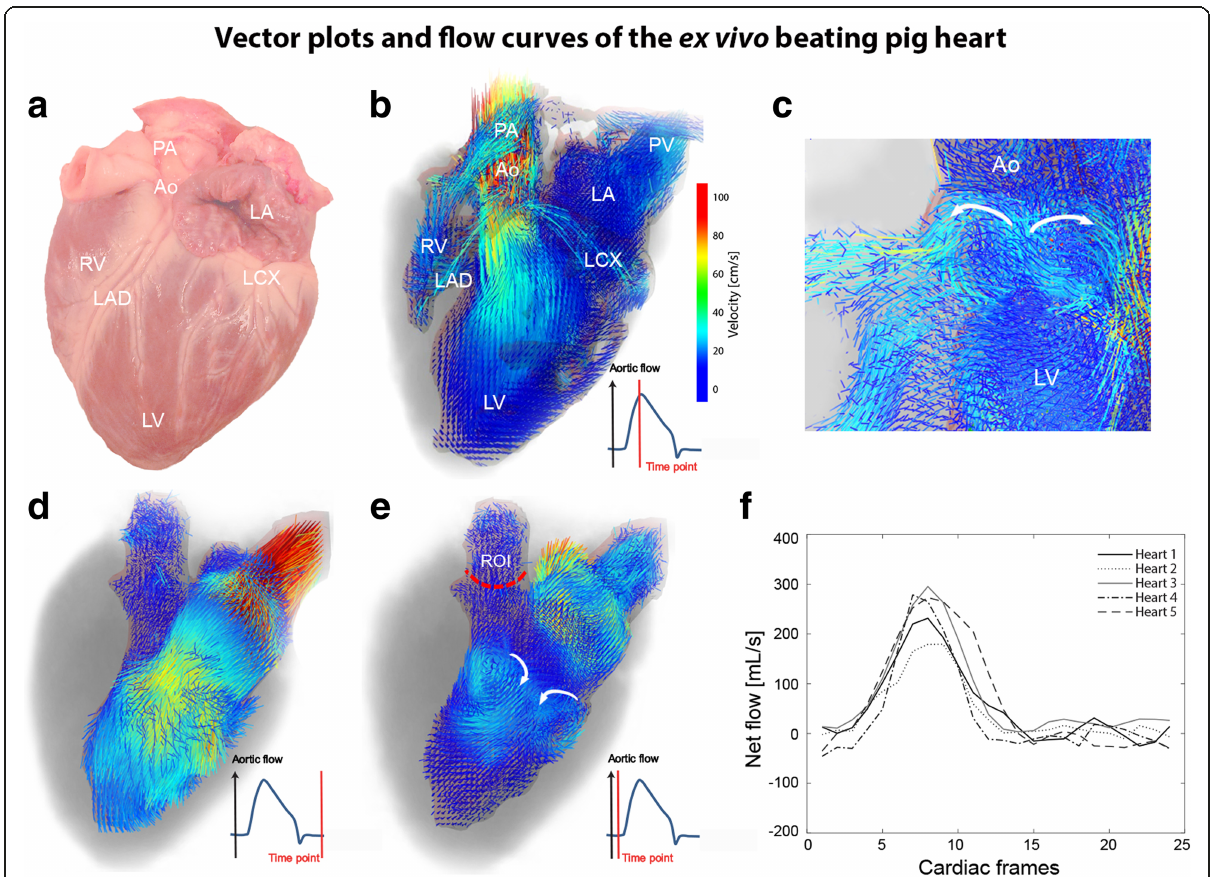
Fig. 2 Velocity vector plots of one representative heart and aortic flow curves for all five hearts. a Anatomical reference of the heart before the experiment. b Vector plots of intracardiac flow in the ejection phase. c Vortex formation and coronary filling in the aortic root of the heart during diastole. For better visualisation of intracardiac flow, d shows the vector plots of the segmented LV at end-systole and e at end-diastole, where vortex formation can be observed. f Net flow downstream to the aortic valve for all five experiments, measured in an ROI indicated in e . Ao Aorta, LA Left atrium, LAD Left anterior descending artery, LCX Left circumflex artery, LV Left ventricle, PA Pulmonary artery, PV Pulmonary vein, ROI Region of interst, RV Right